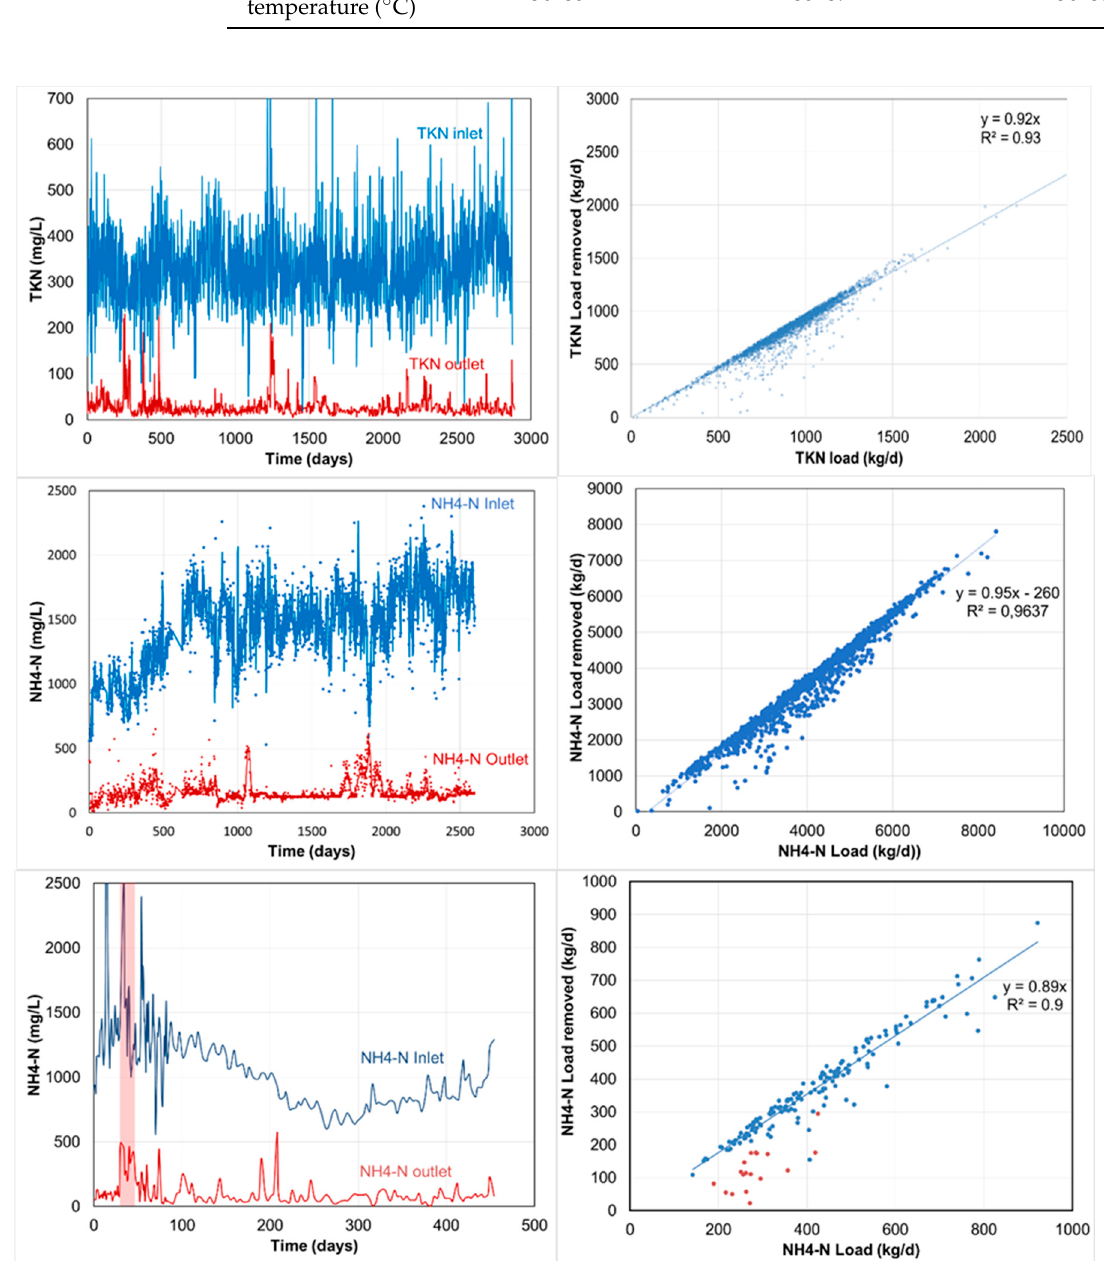
Figure 7. Long-term operation performance of ANAMMOX reactors of case studies described in Table 2: Case I ( top ); Case II ( middle ) and Case III ( bottom ). The graph on the left depicts the nitrogen concentrations (mg/L) while the graph on the right depicts the nitrogen removal as a function of the nitrogen loadings (kg/d).